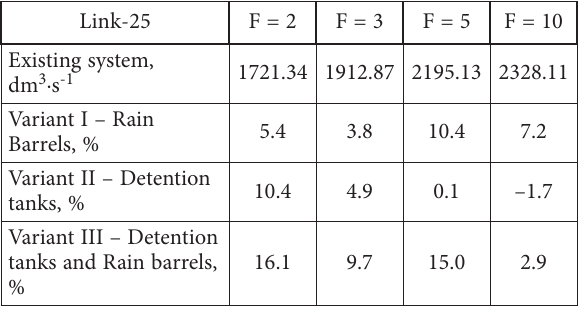
Table 2. Reduction of flow in section Link-25